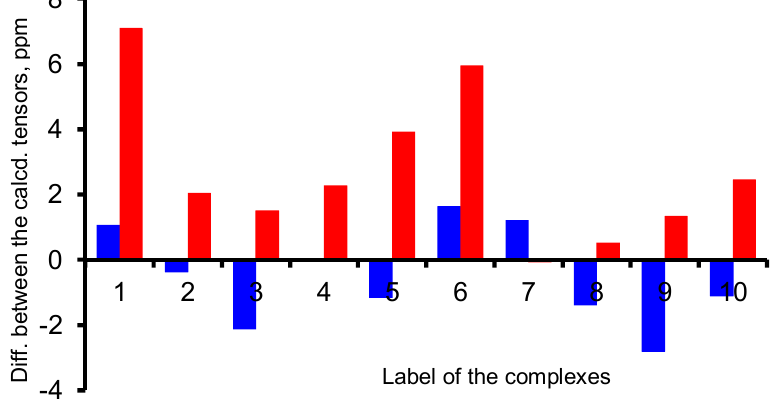
for 10 Al(III) complexes. The blue bars Al are calculated Al ) ] 3+ , [Al(oxalate) ] 3 − 2 6 3